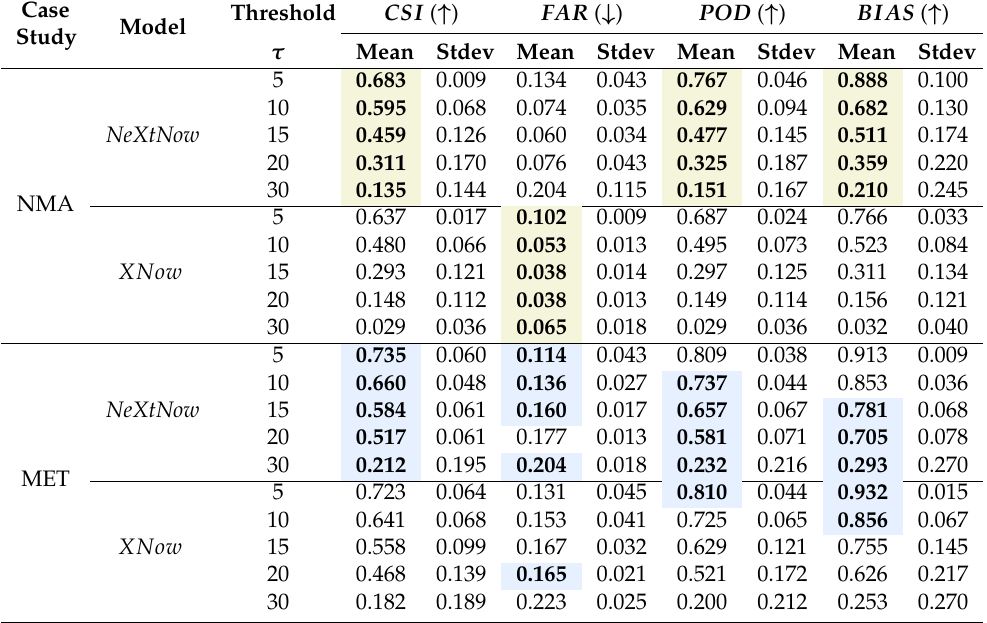
Table 7. The results for the classification metrics for the NeXtNow and XNow models, which were trained using one previous time step ( k = 1) for predicting one time step in the future using both the NMA and MET datasets. The means and standard deviations that were computed across the three experimental runs are shown. The best values for the performance metrics are marked with bold and colored with yellow (for the NMA case study) and with blue (for the MET case